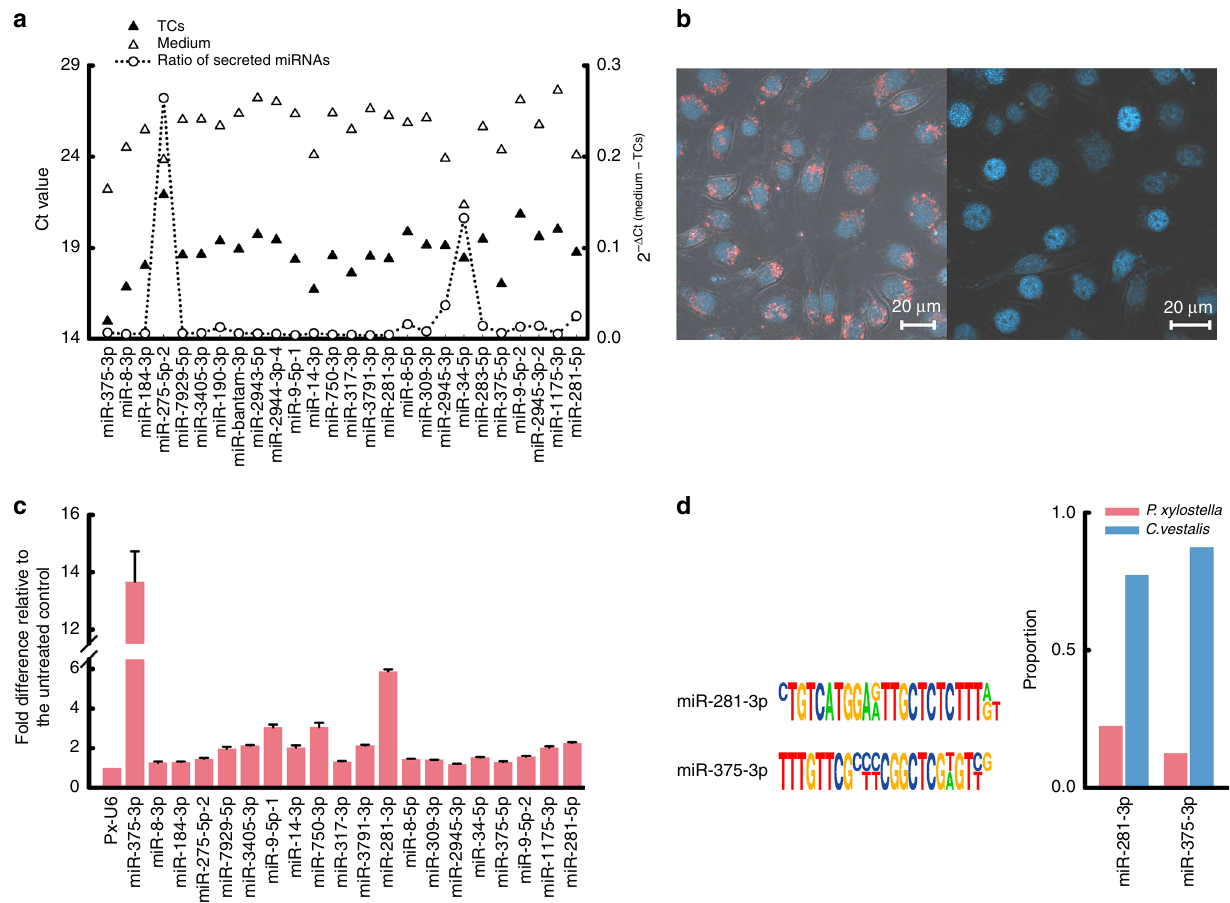
Fig. 3 Teratocytes release miRNAs into the host. a Ct values (left axis) for 30 miRNAs detected in primary cultures of teratocytes and medium conditioned by teratocytes. Each primary culture contained 1 × 10 5 teratocytes in 1 ml of medium, which were each extracted for isolation of miRNAs after 24 h in primary culture. The abundance ratio (right axis) for each miRNA detected in the medium and in teratocytes is indicated by open circles connected with a dotted line. b Uptake by Pxem_cells of exosomes labeled with Alexa fl our 568 (left). Pxem_cells incubation with cultured medium without fl uorescent stain was used as control. Red: Alexa fl our 568 NHS; Blue: DAPI. c Detection of the 30 most highly expressed miRNAs in teratocytes in Pxem_ZJU cells after co- culturing for 6 h. The y axis shows fold differences for each miRNA in Pxem_ZJU cells co-cultured with teratocytes versus Pxem_ZJU cells cultured without teratocytes using the P. xylostella U6 snRNA as the endogenous control. d Sequence comparison of two miRNAs between C. vestalis and P. xylostella . Sequence differences of two miRNAs between C. vestalis (lower line) and P. xylostella (upper line) are shown on the left. Proportion of two different isoforms of miR-281-3p and miR-375-3p in parasitized P. xylostella larval hemocytes ( n = 100) (right). The pink columns represent the proportion of miRNAs from P. xylostella and the blue ones represent that of C. vestalis miRNAs. Primers were designed based on the miR-281-3p and miR-375-3p from C. vestalis and P. xylostella . PCR-ampli fi ed fragments were cloned and sequenced, and the difference sequence numbers were calculated. Results shown are mean relative abundance ± s.e.m. of each miRNA from three independent biological